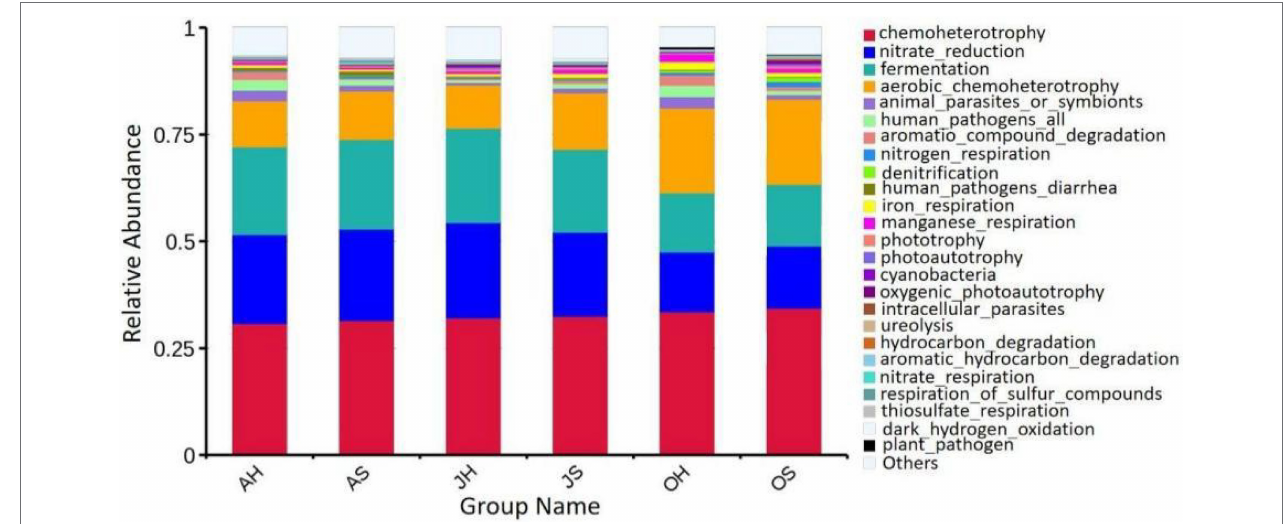
FIGURE 7 | Relative abundance of putative functions of epiphytic bacteria in M. spicatum from Baiyangdian